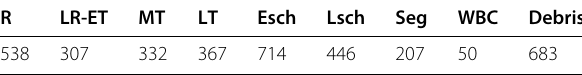
Table 3 Number of parasites in each